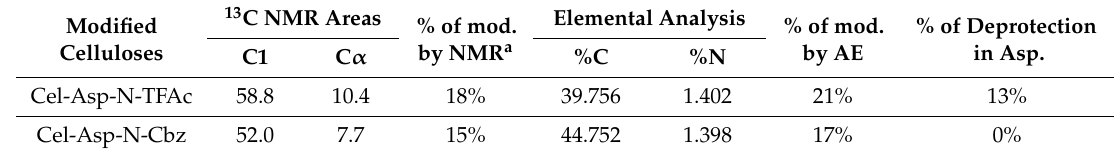
Table 1. Percentage of cellulose modification determined by 13 C NMR and elemental analysis. Column 6 shows the deprotection degree (%) in aspartic residues evaluated by ninhydrin method (details about these calculations are described in Supplementary Material by means of Table S2 and Figure